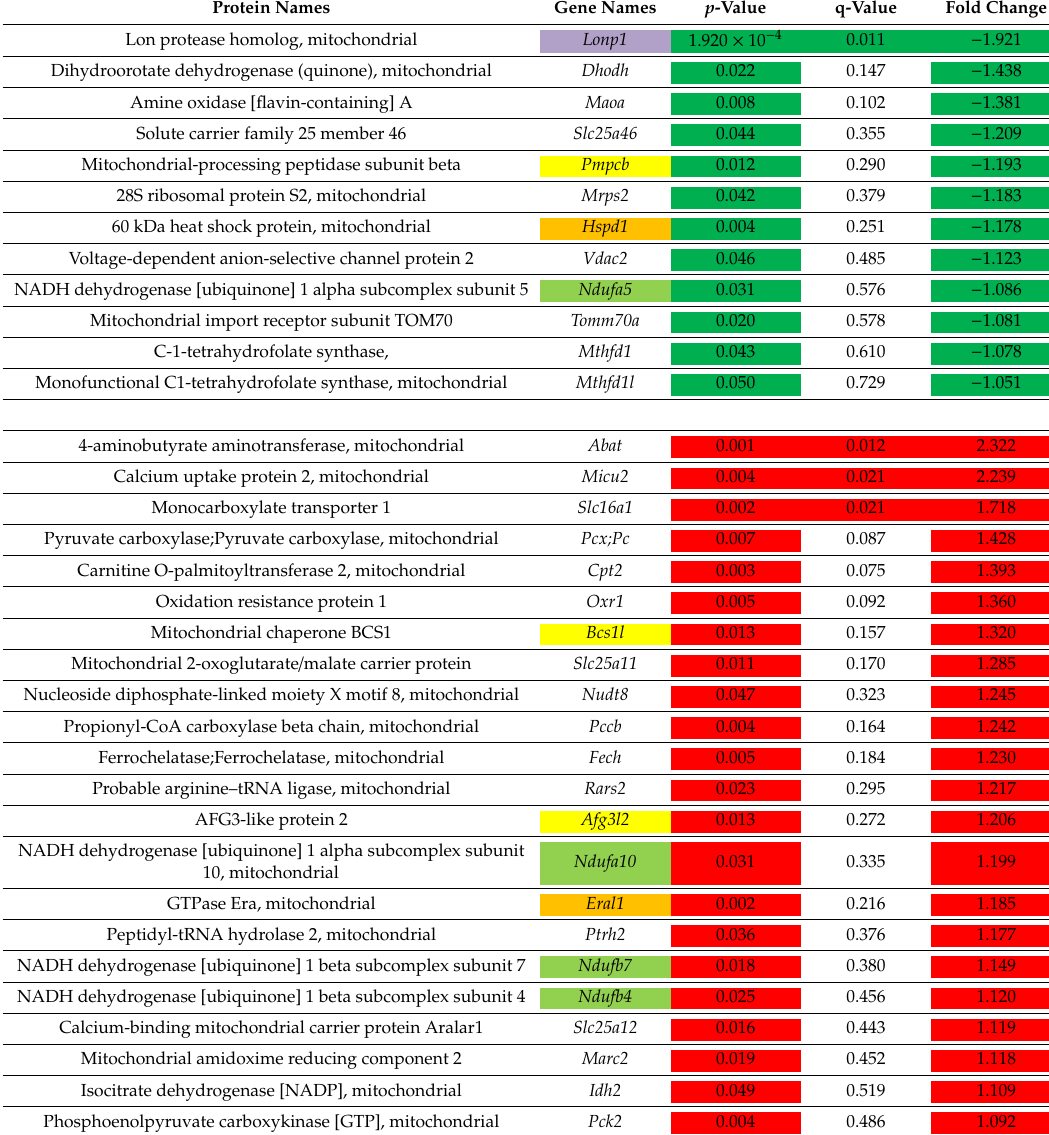
Table 1. List of mitochondrial factors with significant dysregulation, ordered by direction of change (dark green color for downregulations, red for upregulations) and by fold-changes. In response to the deficiency of the AAA + domain containing peptidase LonP1 (purple), several AAA + domain containing factors and proteases (highlighted in yellow), as well as two chaperones (orange), were altered. Several subunits of the respiratory complex-I stood out (green), with upregulations of three subunits in the membrane arm (P module) [60], while one subunit in the matrix arm of iron / sulfur and flavoproteins (NQ modules) showed a minor